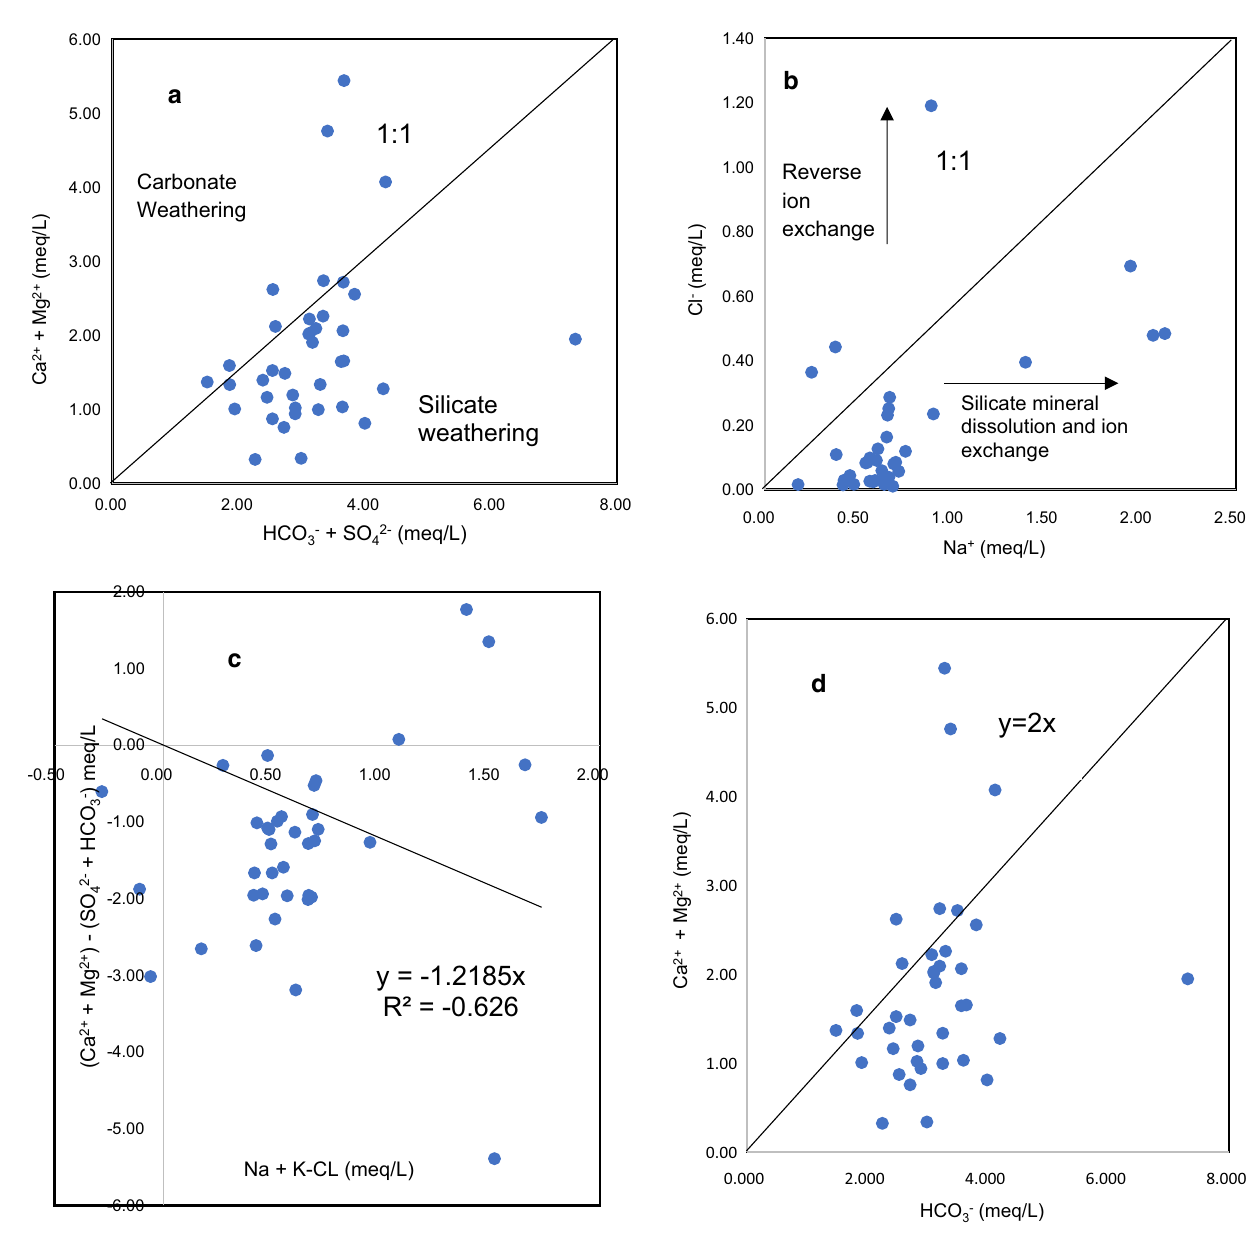
Fig. 10 Bivariates plots of a Ca 2+ + Mg 2+ (meq/L) against HCO 3− (meq/L) + SO 42− b Na + (meq/L) against Cl − (meq/L) c (Ca 2+ + Mg 2+ ) – (SO 42− + HCO 3− ) meq/L against Na + + K + -Cl − meq/L d Ca 2+ + Mg 2+ against HCO 3